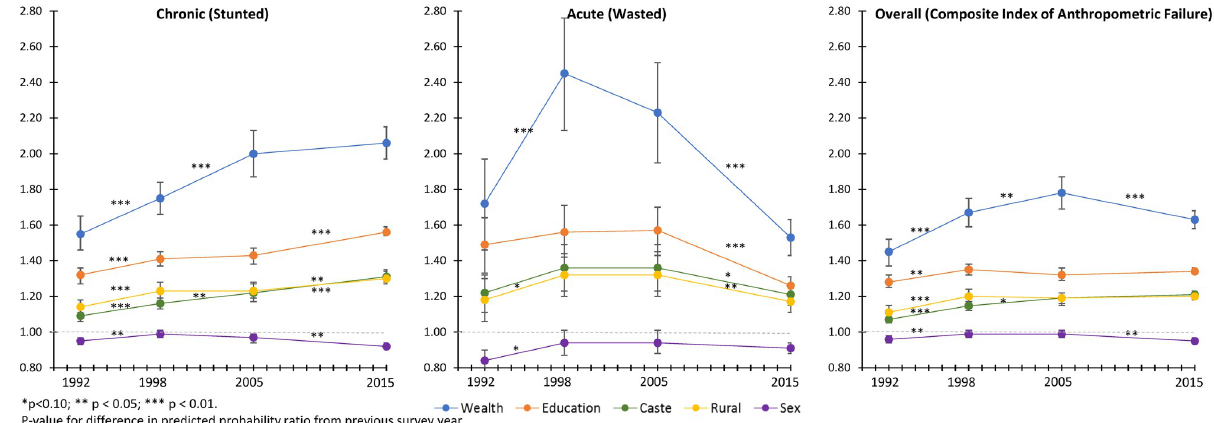
Fig 3. Trends in disparities for undernutrition among Indian children aged 3 or less based on wealth, maternal education, caste, location of residence, and child sex. Data from the 1992, 1998, 2005, and 2015 NFHS. NFHS, National Family Health Survey. Predicted probability ratio for wealth (lowest quintile/highest quintile), maternal education (none/secondary or higher), caste (scheduled caste or tribe/general), location of residence (rural/ urban), and child sex (female/male) were estimated after mutually adjusting for each other as well as child’s age, birth order, religion, and maternal age.